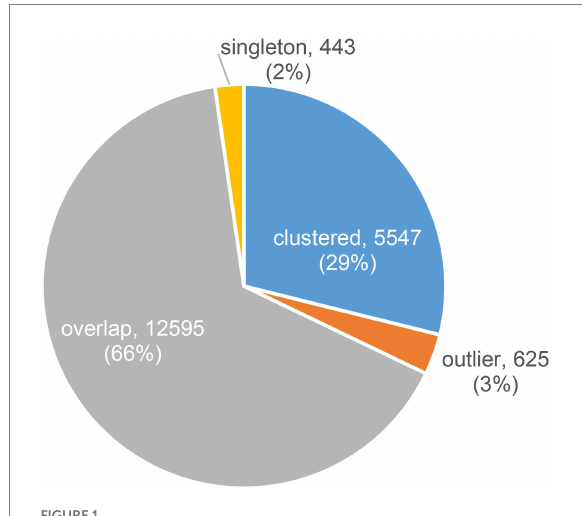
FIGURE 1 Distribution of contigs according to their clustering result based on their shared proteins using